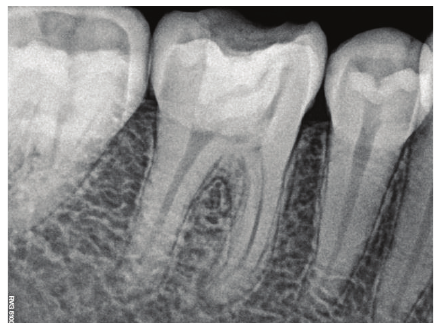
Figure 30: 6-month followup RVG 36.